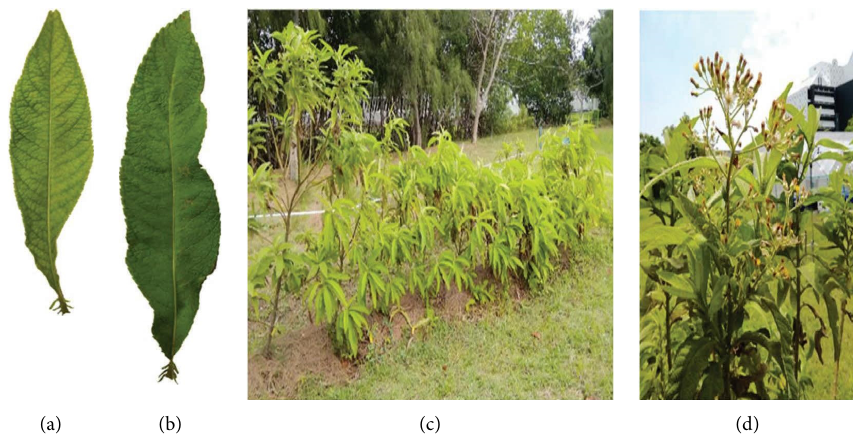
Figure 1: Visual appearances of an immature leaf (a), a mature leaf (b), whole plants of the B. balsamifera plant (c), and the plant while fowering